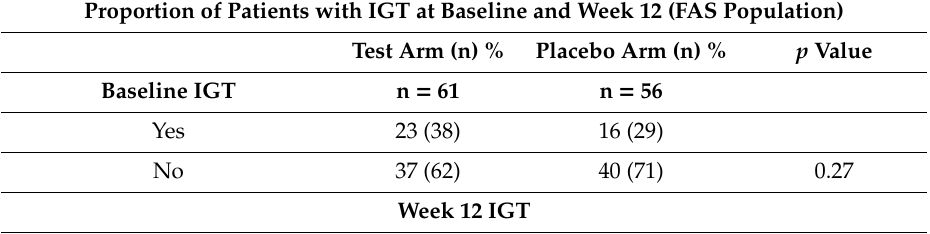
Table 3. Impaired glucose tolerance for the FAS population and PP population.